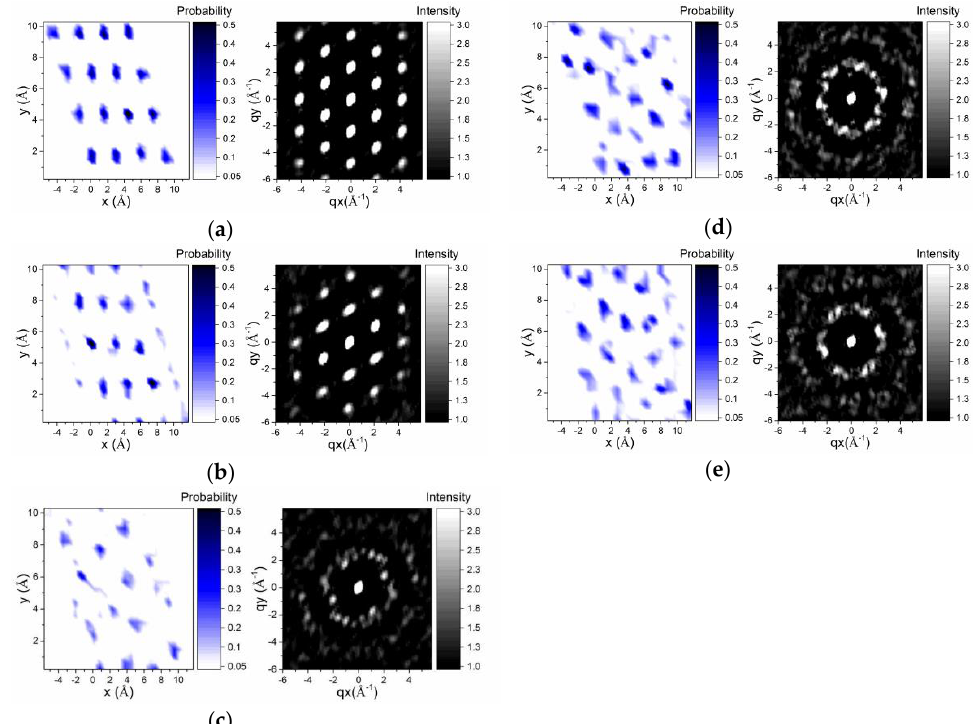
Figure 3. In-plane atomic distribution (the left one in each picture) and two-dimensional (2D) structural factor (the right panel in each image) of ( a ) LL1-TiB 2 , ( b ) LL2-TiB 2 , ( c ) LL3-TiB 2 , ( d ) LL1-sapphire, and ( e ) LL2-sapphire.